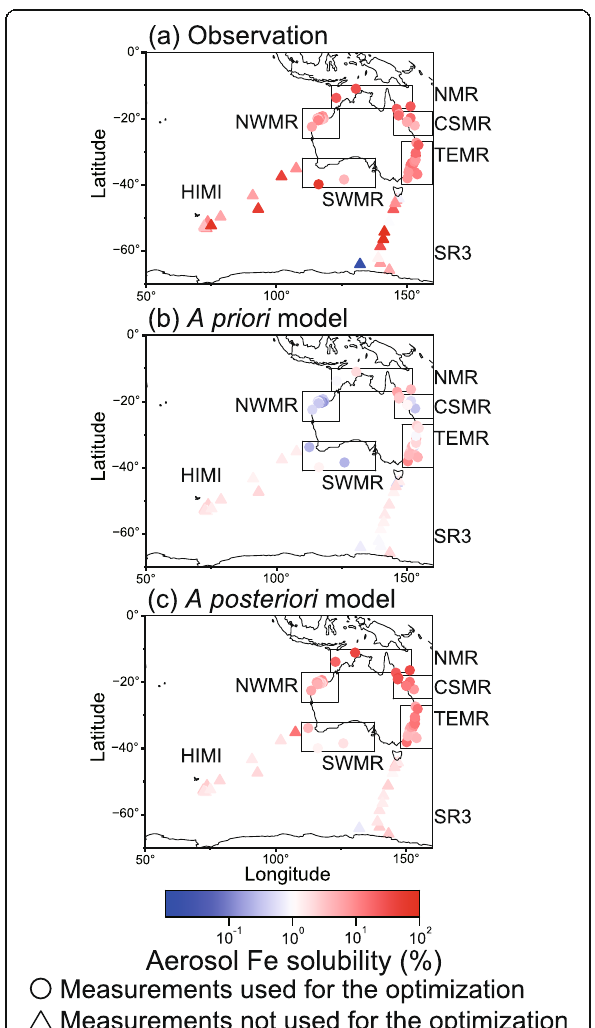
Fig. 6 Spatial distribution of aerosol Fe solubility (%) for a observations, b a priori model estimates, and c a posteriori model estimates over the 70°E – 150°E and 10°S – 70°S sector of the SH